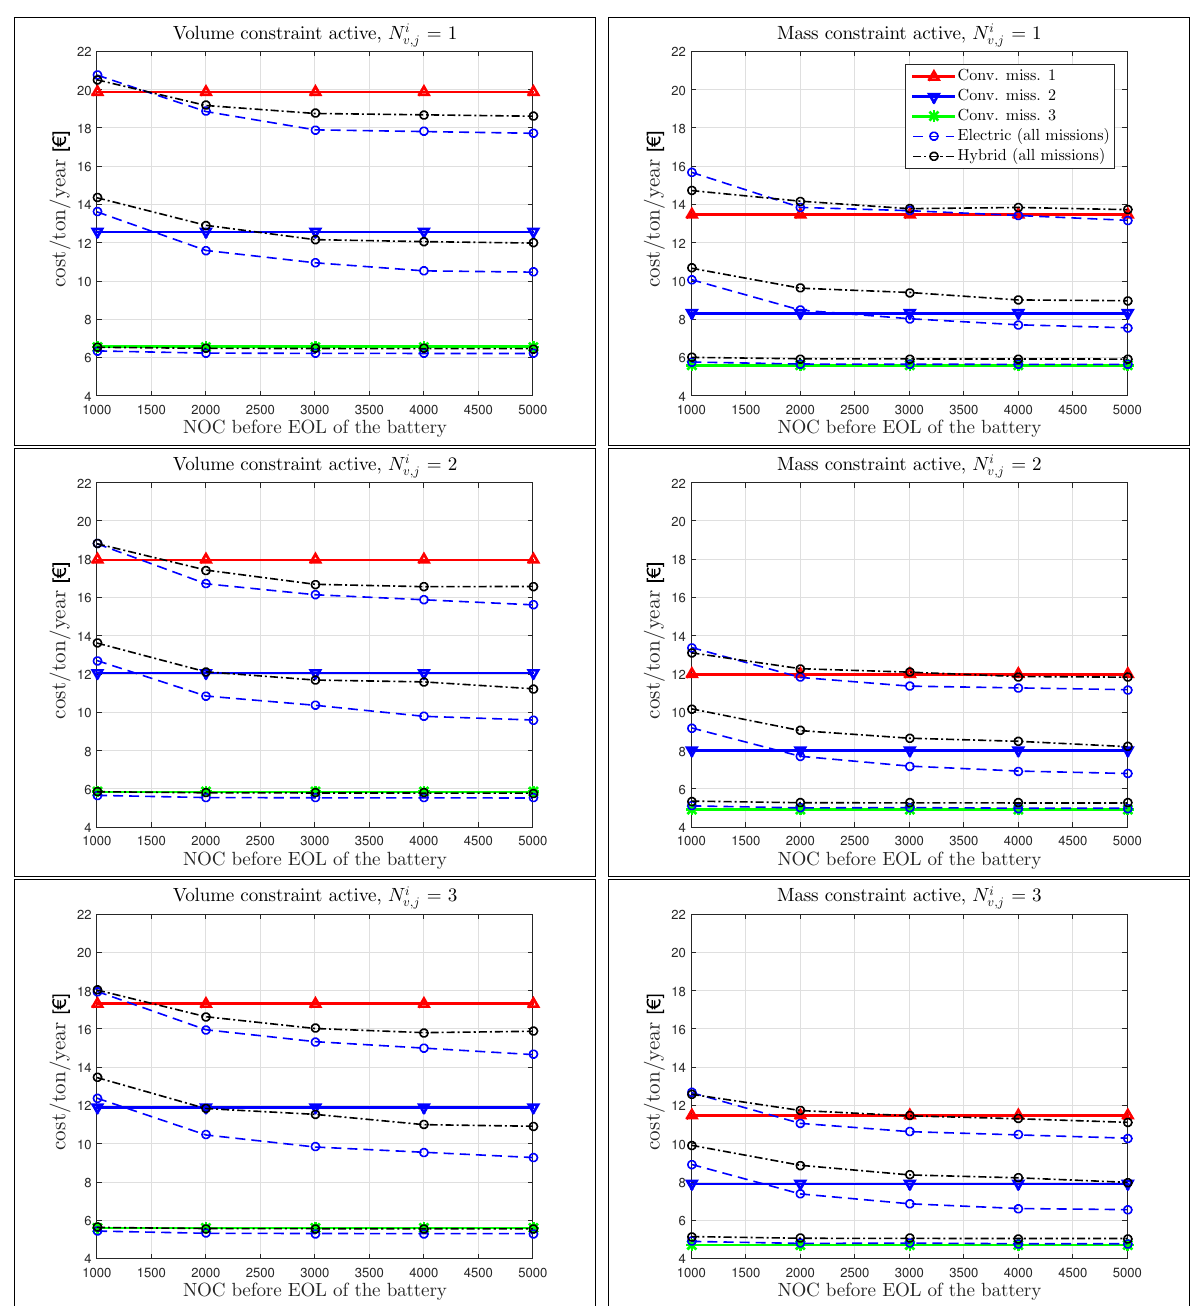
Figure 19. Competitiveness between conventional, fully electric, and hybrid vehicles in terms of the unit transportation cost of different optimally designed vehicles. Each small circle corresponds to an optimized vehicle with different hardware. For all plots, maximum working time per day is 16 h